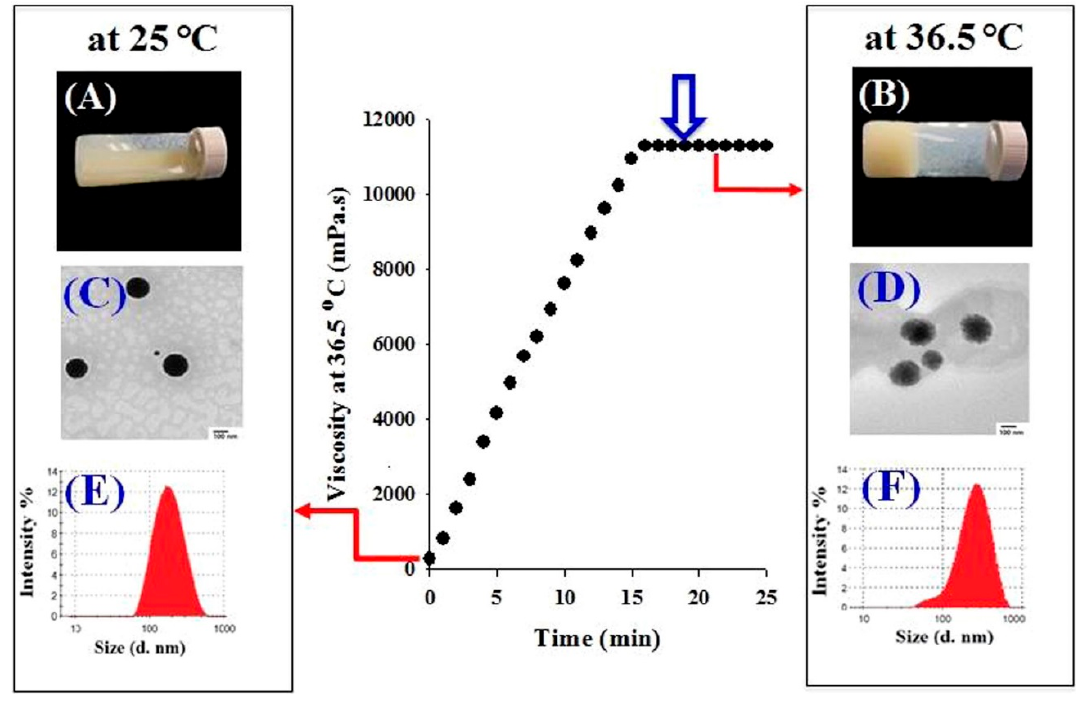
Figure 6. Schematic representation of the irinotecan-loaded SLN-hydrogel system behavior at 25 °C and 36.5 °C. Adapted from